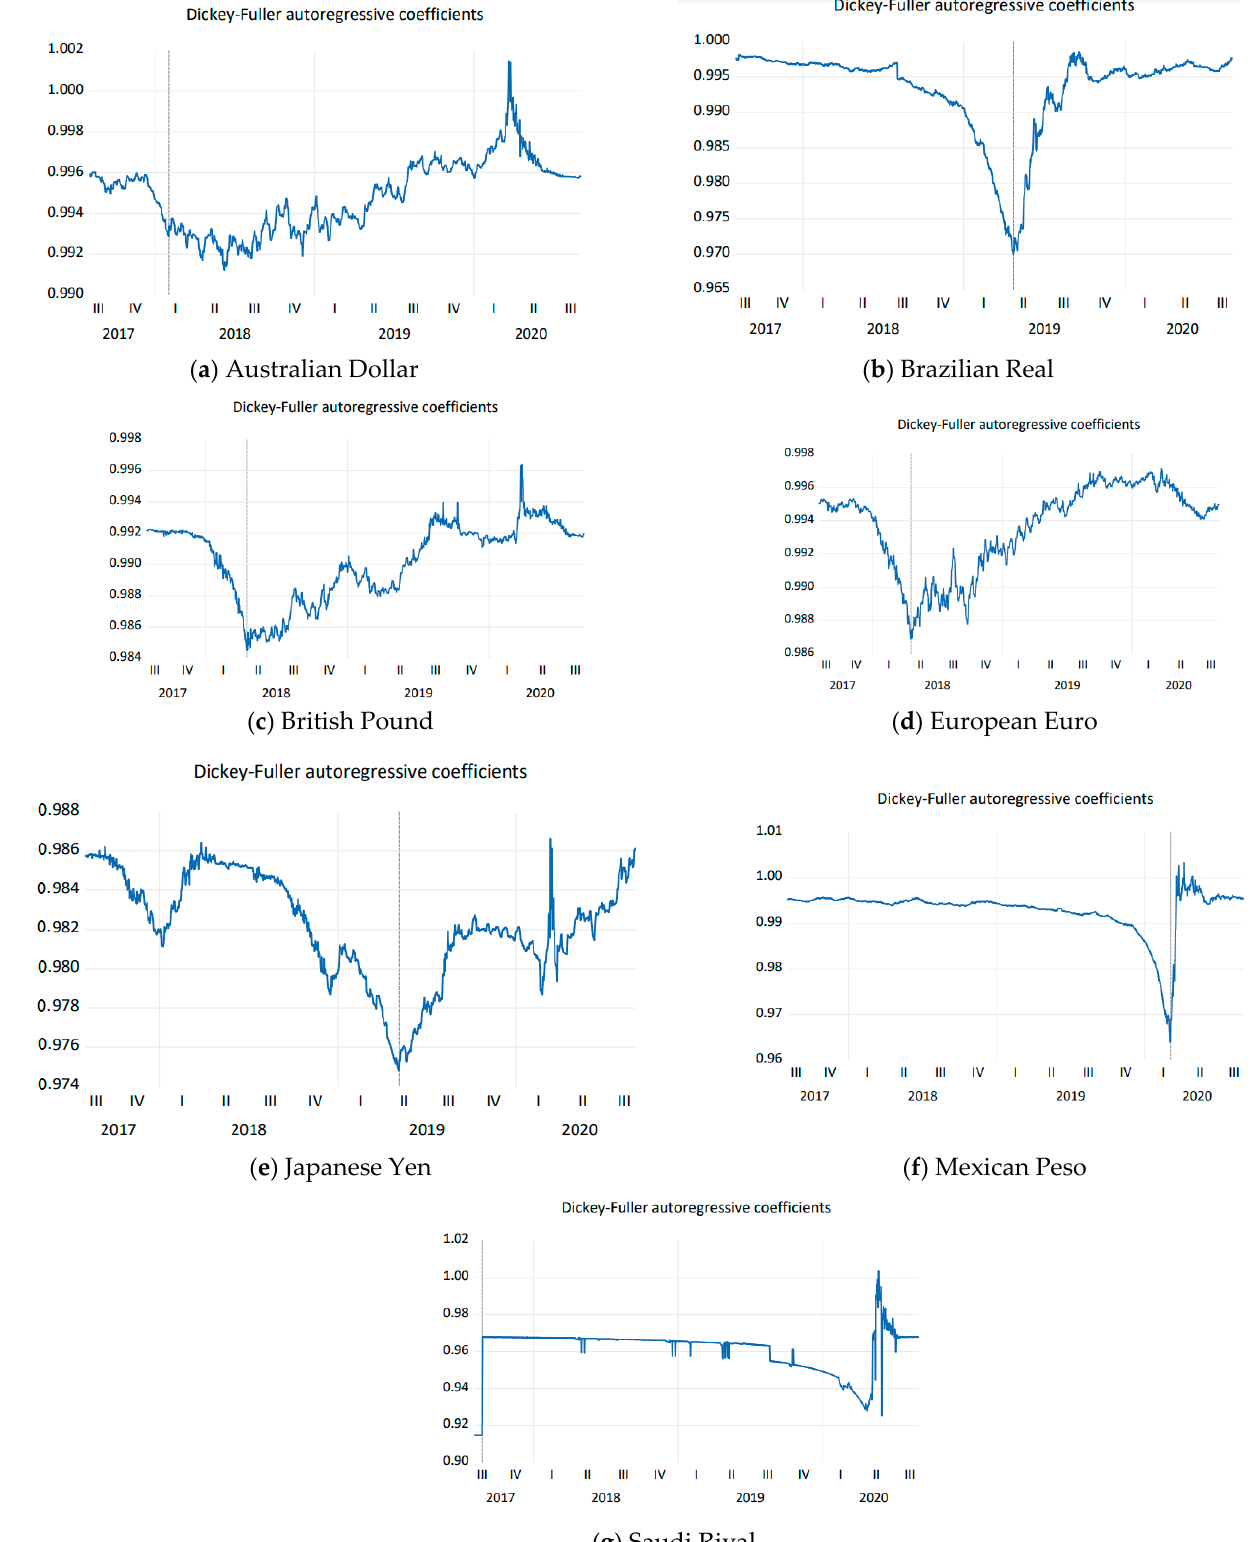
Figure 6. Dickey–Fuller autoregressive coefficients for seven FOREX Currencies.